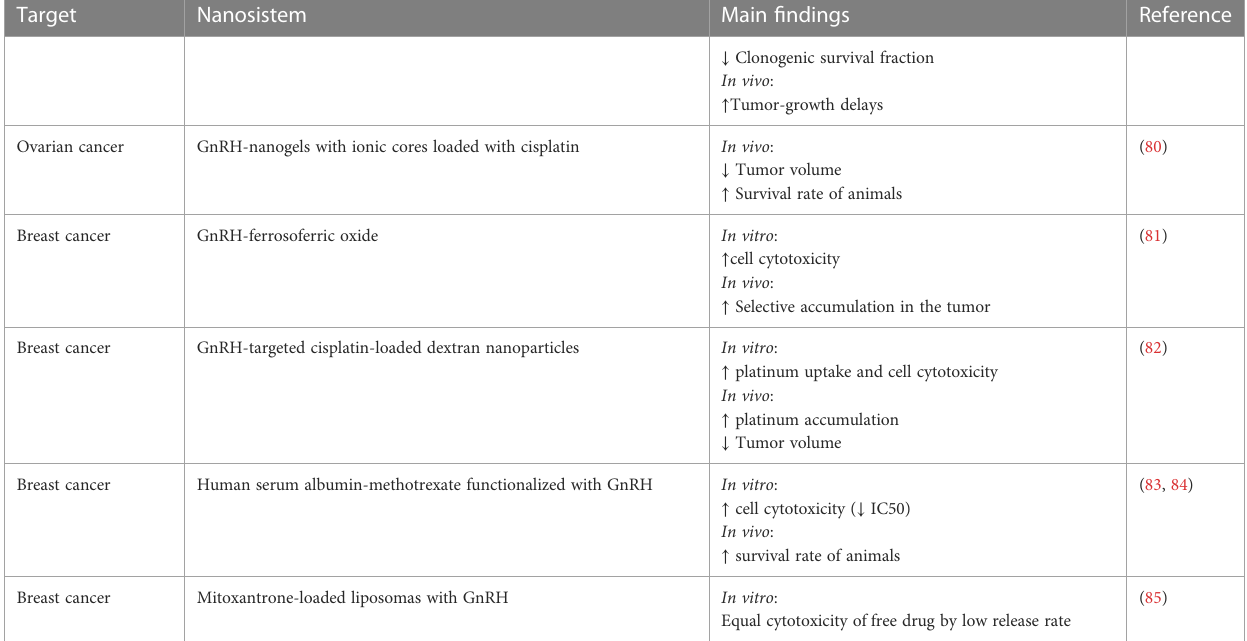
Arrows indicate an increase ( ↑ ) or decrease ( ↓ ) of tumoral